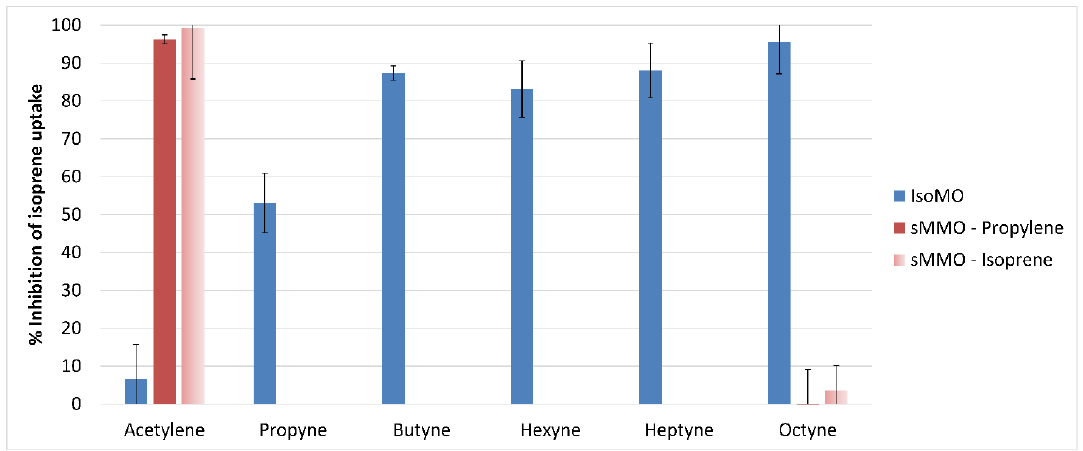
Figure 5. Differential inhibition of IsoMO and soluble methane monooxygenase (sMMO) by C2–C8 alkynes (50 µM), where DMSO acts as a control for C6–C8 alkynes since C6–C8 alkynes were dissolved in DMSO before addition.